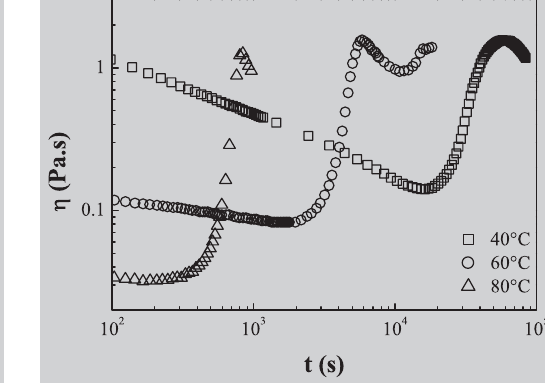
Figure 9 (left): Concentration dependence of the critical shear stress for submicelle solutions. Results obtained at different temperatures between 40 and 90ºC were the same within the experimental noise. The solid line has slope 3. Figure 10: Time dependence of the viscosity for a submicelle suspension at 120 g/L heat- ed at different temperatures indicated in the figure. The shear rate was 10 s -1